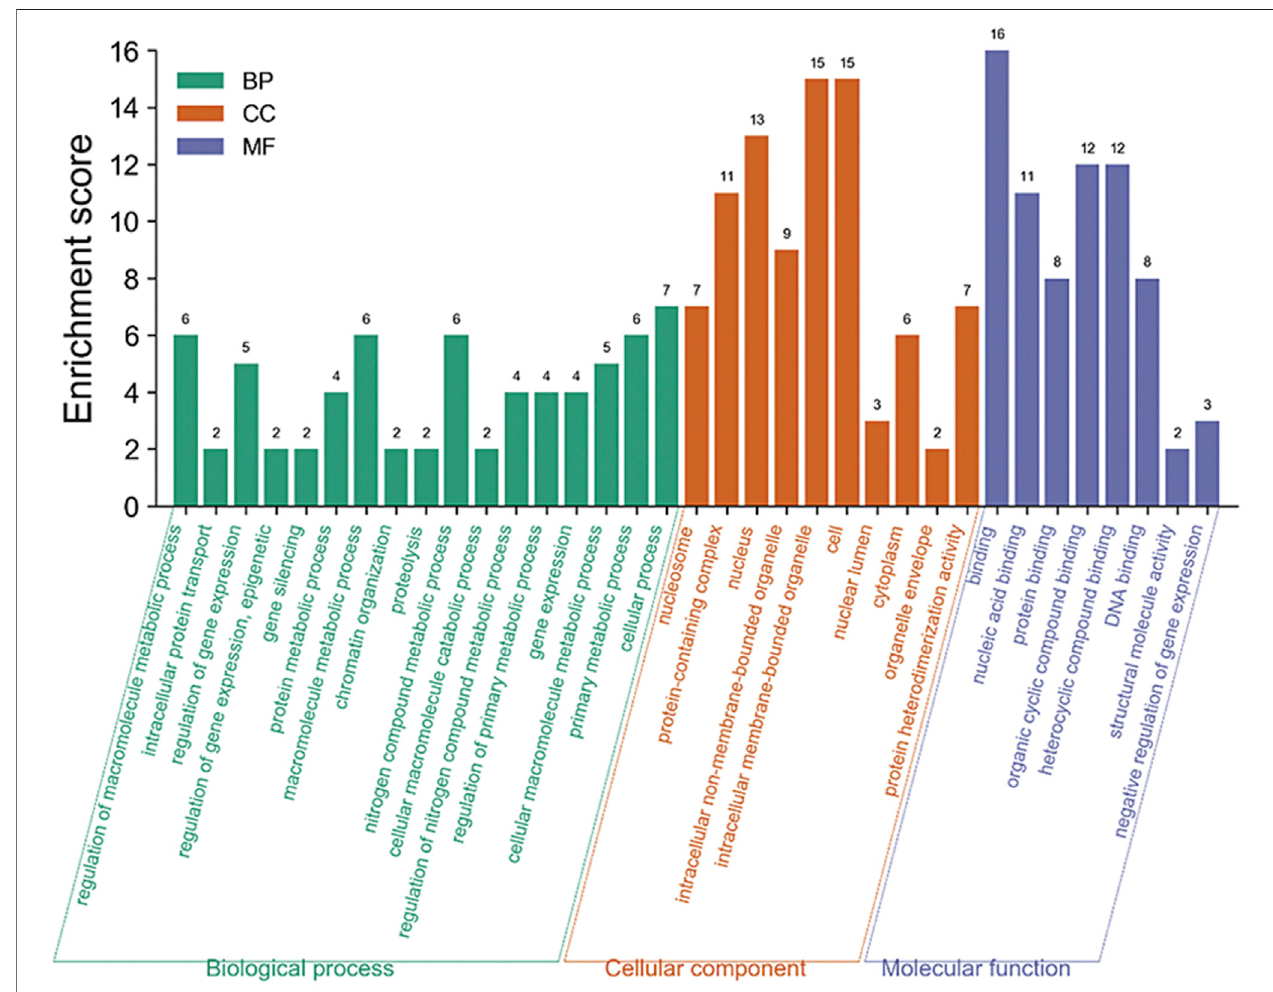
FIGURE 11 | GO pathway enrichment analysis diagram of rice core